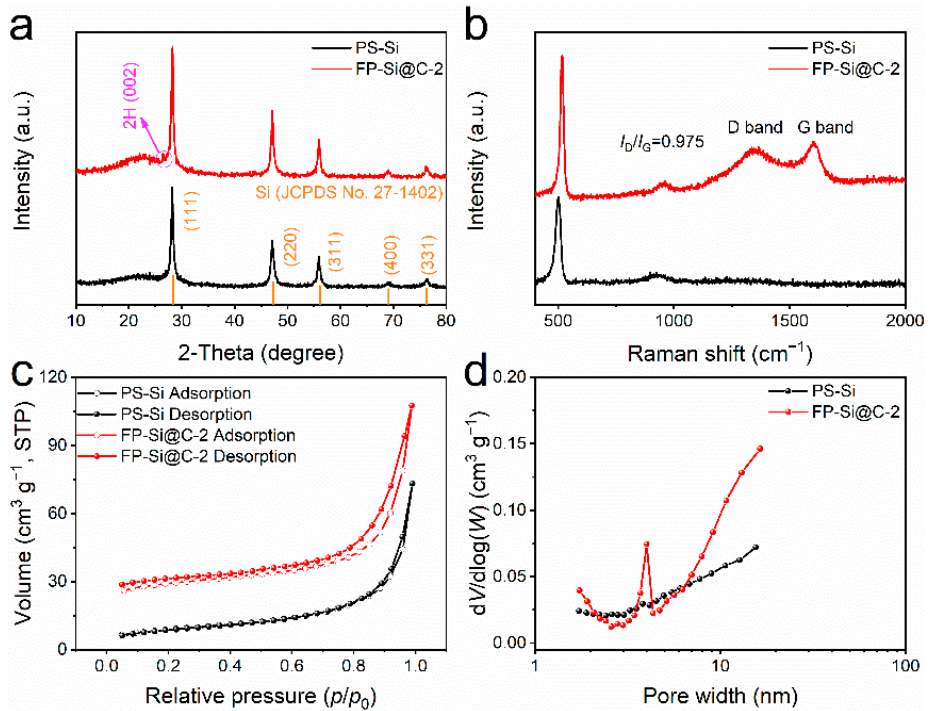
Figure 2. ( a ) XRD patterns, ( b ) Raman spectra, ( c ) N2 adsorption–desorption isotherms, and ( d ) pore size distribution of P-SiCW and FP-Si@C-2.